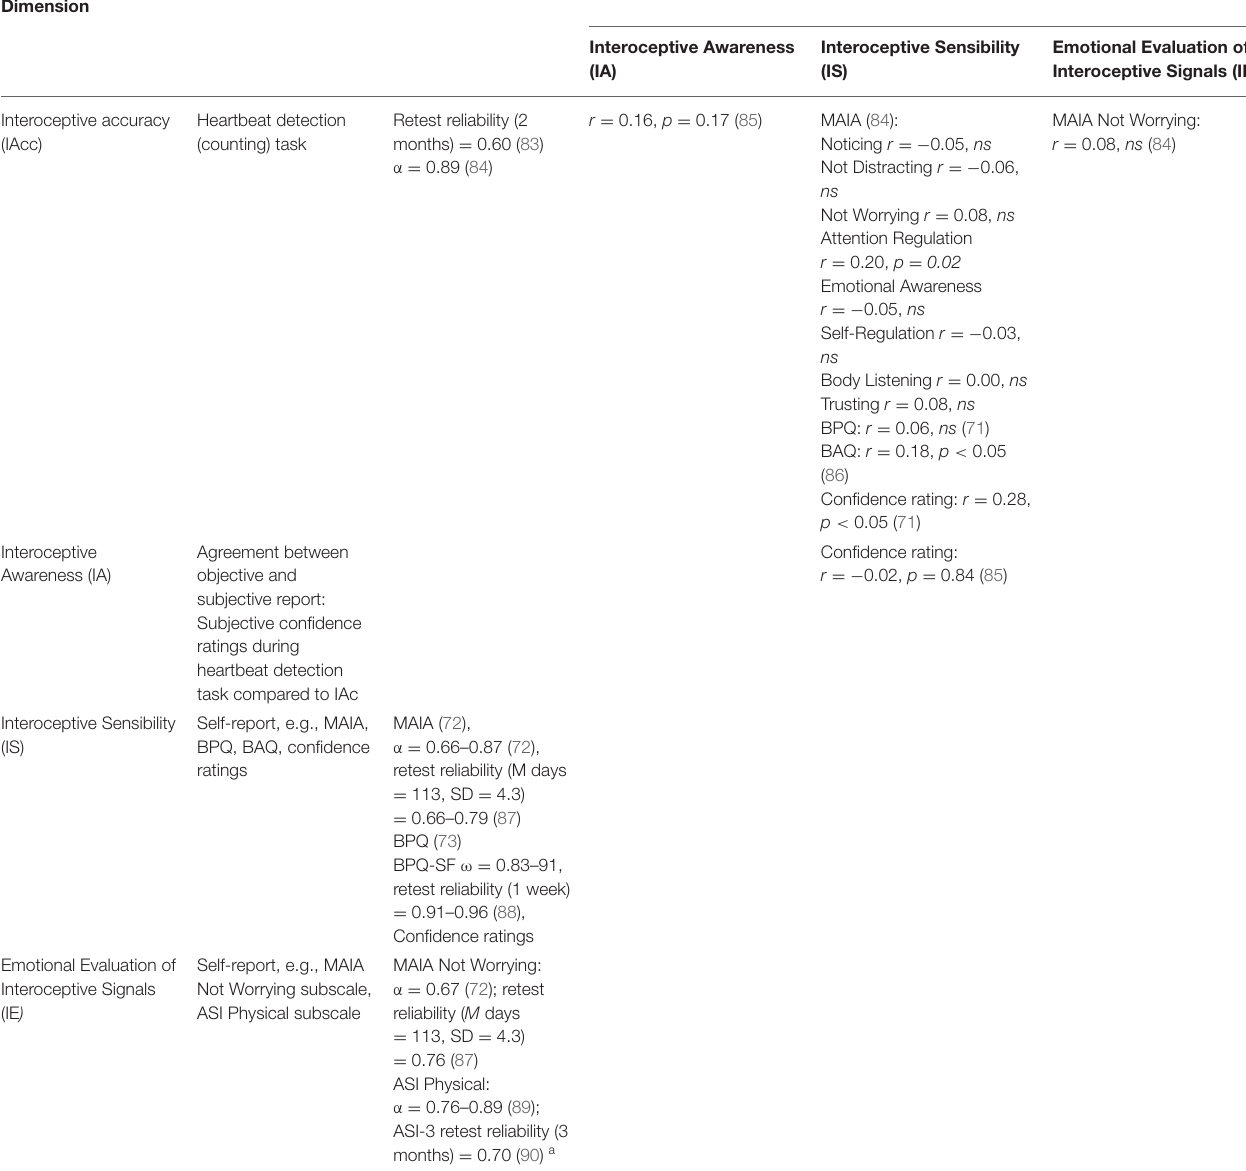
TABLE 2 | Reliability and validity of select interoceptive assessments. Interoceptive